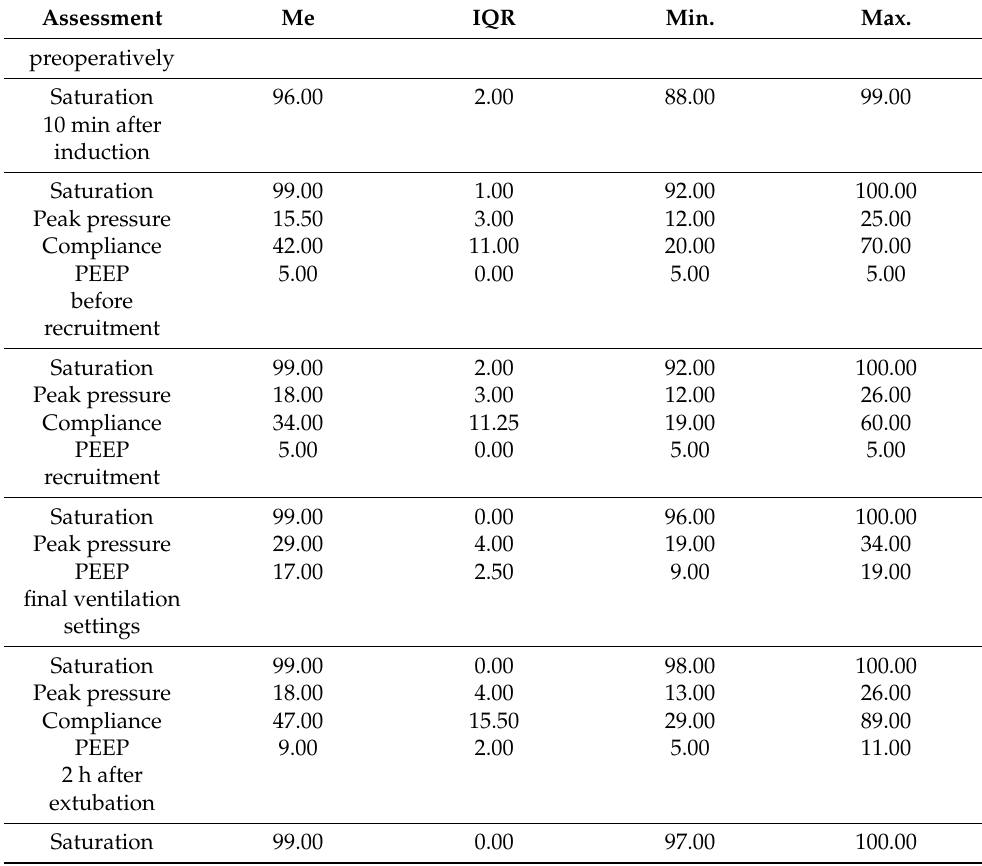
Table 3. Basic statistics for peak pressure, PEEP, saturation and compliance at consecutive stages of the